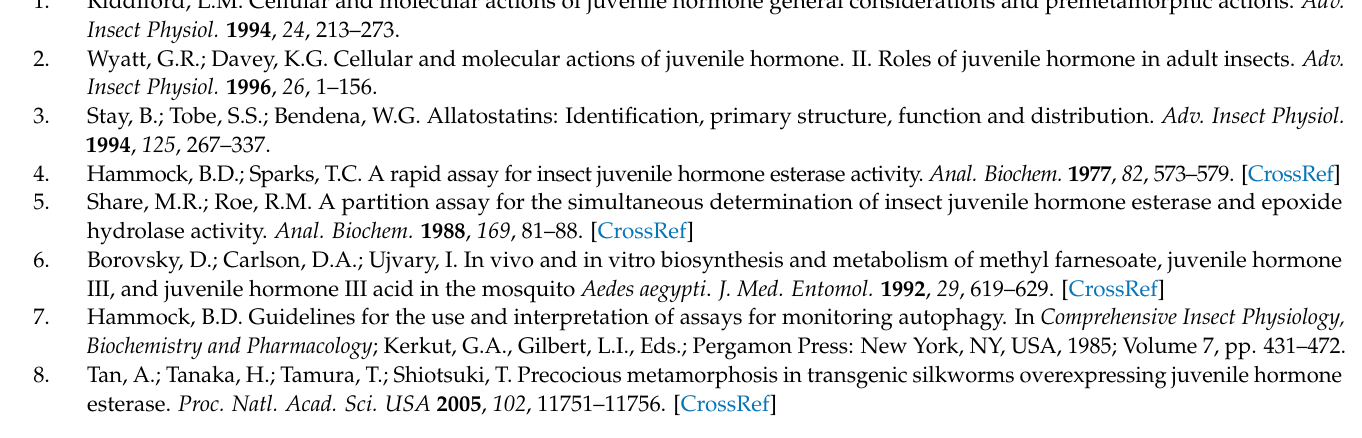
Figure S2: jheh 1 promoter sequence; Figure S3: jheh 2 promoter’s partial sequence (1325 bp); Figure S4: jheh 3 promoter’s sequence (1562 bp); Figure S5: Effect of farnesoic acid (1 µ M) on transcriptional activity of transformed D.Mel2 cells with different length jheh 3 promoter constructs; Table S1: Primers used for sequencing D. melanogaster JHEH 1 cDNA; Table S2: Primers used for sequencing D. Table S4: Primers used for testing D. melanogaster JHEH 1 promoter; Table S5: Primers used for testing D. melanogaster JHEH 2 promoter; Table S6: Primers used for testing D. melanogaster JHEH 3